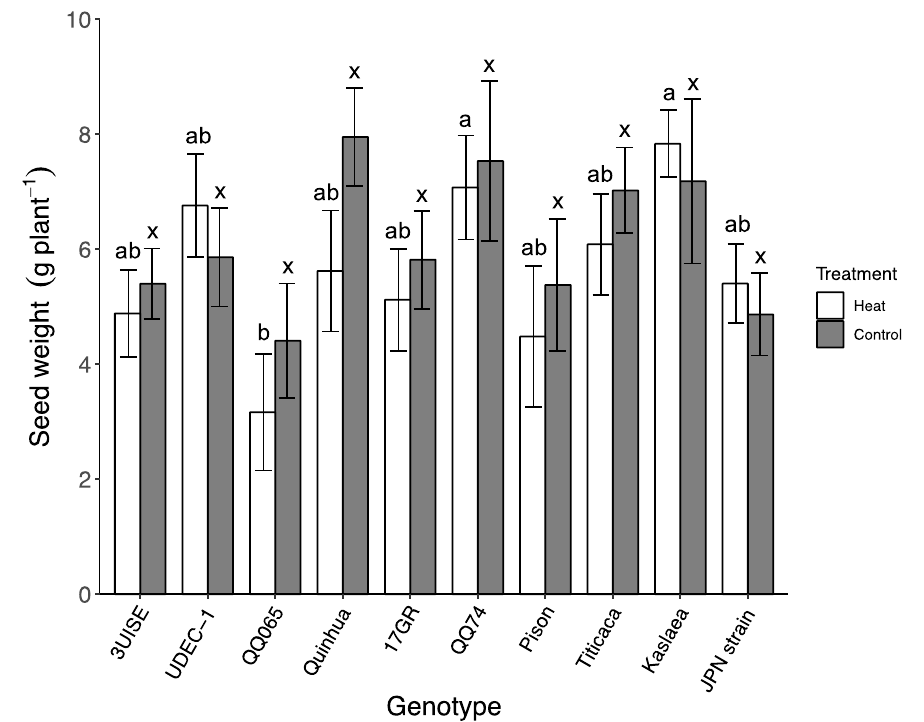
Figure 7. Seed weight (g plant −1 ) in 10 quinoa genotypes exposed to a four-day heat treatment (45 °C/30 °C) and control treatment (20 °C/14 °C); day and night, respectively. Values are means ± SE ( n = 10–12). Mean comparisons are shown for within temperature treatment (Heat: a to b; Control: x); different letters are significantly different at p < 0.05. No differences were found for temperature treatment within genotype.